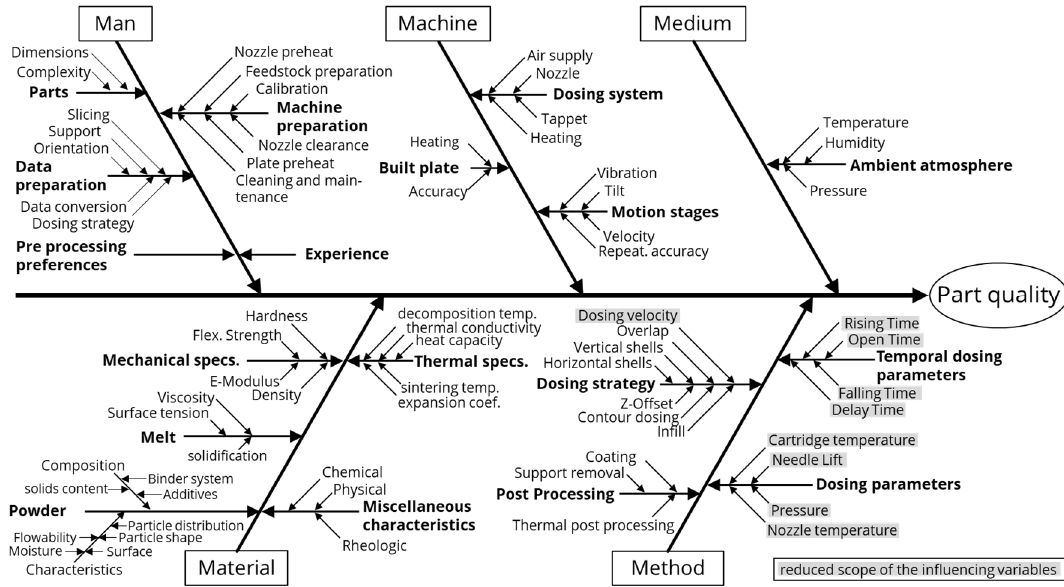
Figure 3. Ishikawa diagram aiming at the part quality of the CerAM MMJ 3D printed parts using the 5M standard categories common in production engineering.